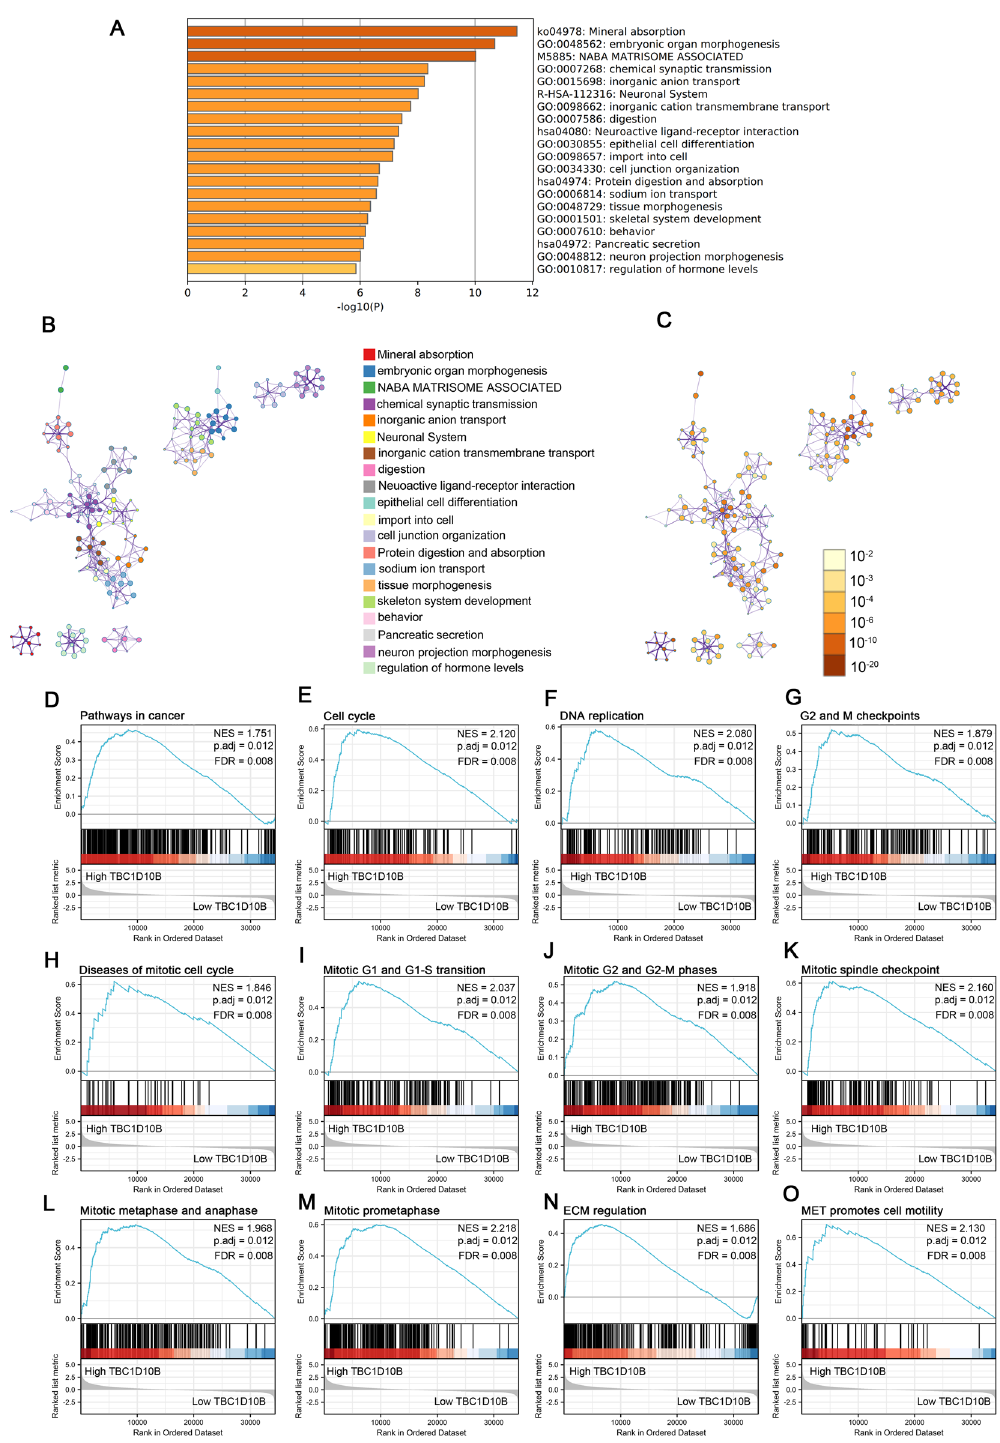
Figure 3. Functional annotation differential expressed genes (DEGs) in LIHC patients with different expression levels of TBC1D10B. We used the Metascape database to perform the functional annotation based on 772 differentially expressed mRNAs between high- and low-TBC1D10B expression groups. Based on the kappa threshold of 0.3, all statistically enriched terms were identified and then hierarchically in to a tree ( A ). The network layout was generated using representative terms from the cluster ( B ). Node size correlates with the number of input genes, different colors represent different cluster. The thickness of the edge based on the similarity score. The same enrichment network presents nodes colored by the P-value ( C ). Representative Gene Set Enrichment Analysis of differentially expressed mRNA between the high TBC1D10B expression group and the low expression group ( D–O